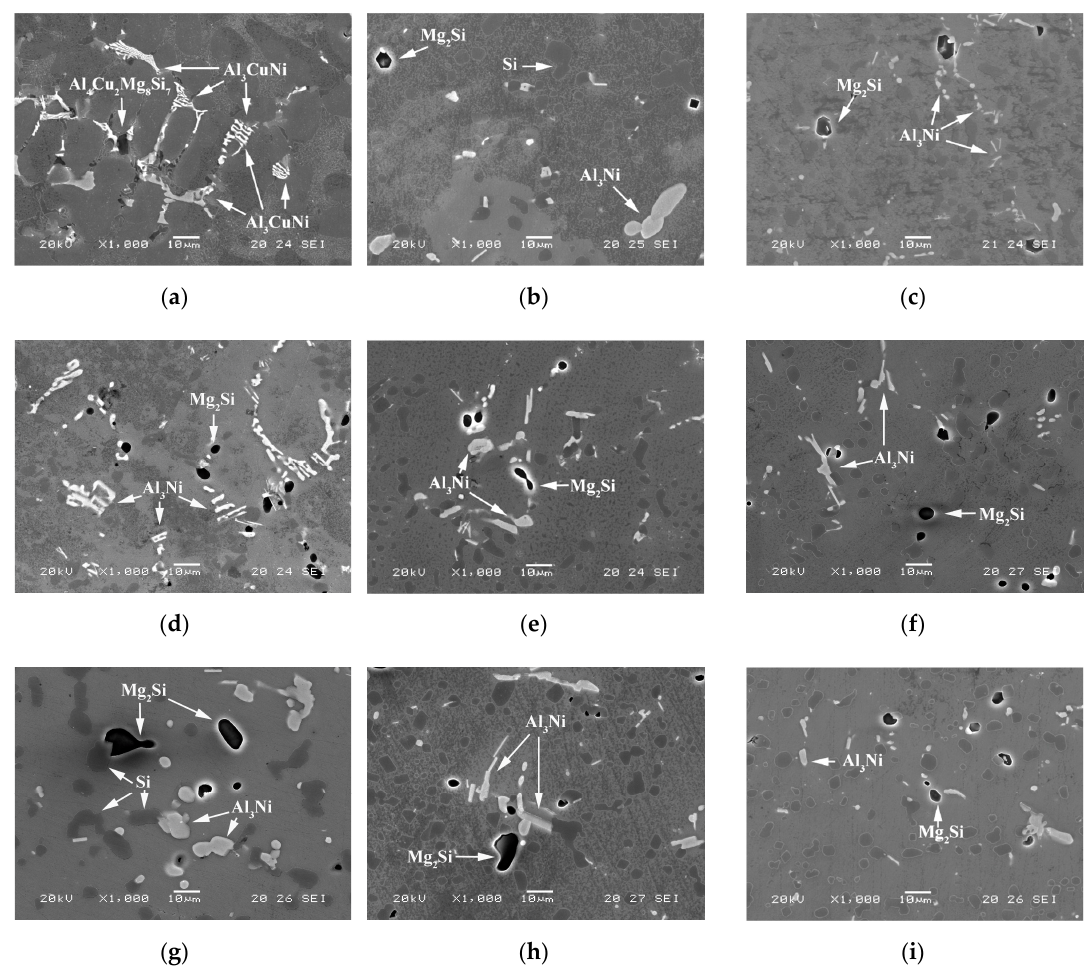
Figure 4. Microstructural evolution. Micrographs obtained by scanning electron microscope (SEM).